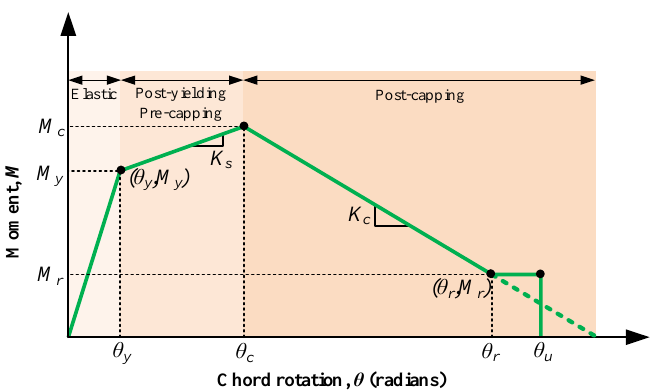
Figure 2. Modified Ibarra Krawinkler moment-rotation relationship for a beam-column joint element.